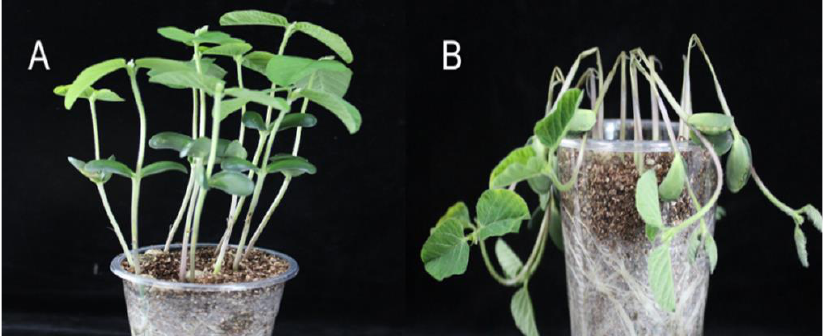
Figure 1. Phenotypes of the two soybean germplasms treated with the P. sojae isolate JS08-12 by hypocotyl inoculation. ( A ) Nannong 10-1; ( B ) 06-070583.